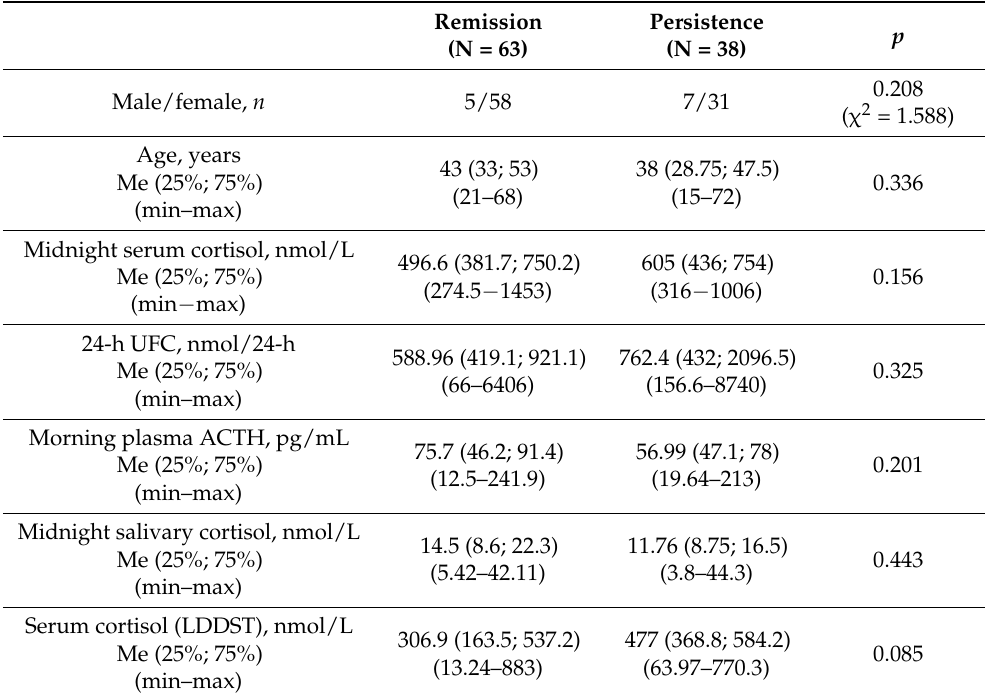
Table 1. Preoperative characteristic and comparison of patients with remission and persistence of CD one year after TSS.